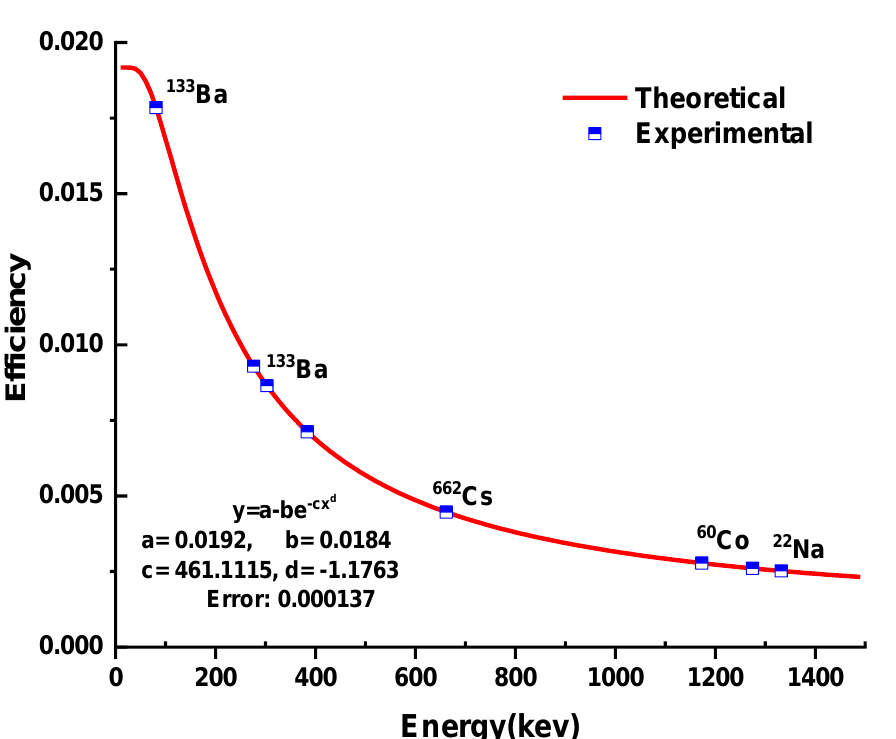
Figure 2. Standard sources are used to calibrate the detector for efficiency.